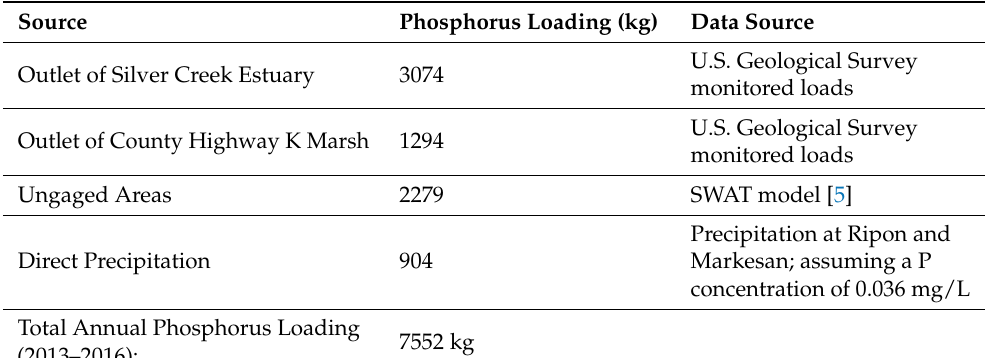
Table 1. Total phosphorous loading to Green Lake by source from 2013 to 2016 [10].